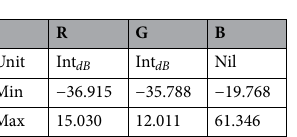
Table 11. Statistical summary of σ